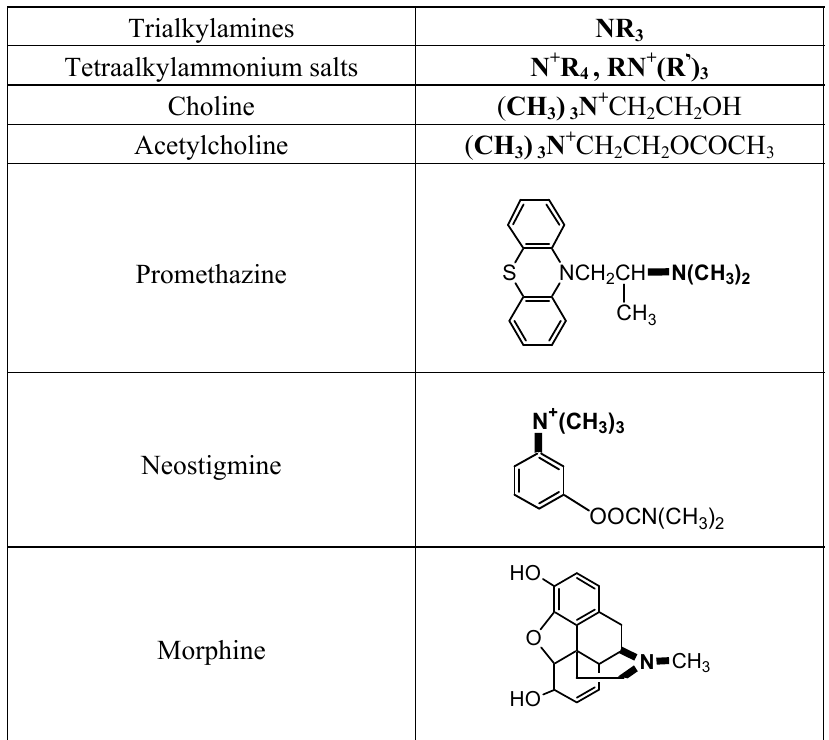
Table 1. Examples of some compounds containing substituted ammonium groups that react with NMBD-reactive IgE antibodies in the sera of patients who experienced an anaphylactic reaction following the administration of a NMBD during anesthesia. Ammonium groups are highlighted. R =